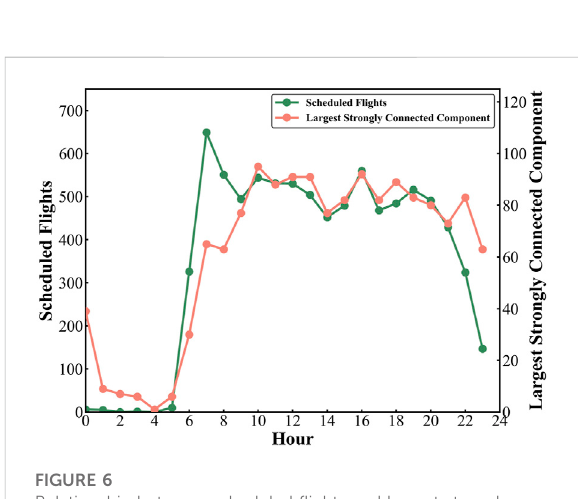
FIGURE 6 Relationship between scheduled fl ights and largest strongly connected